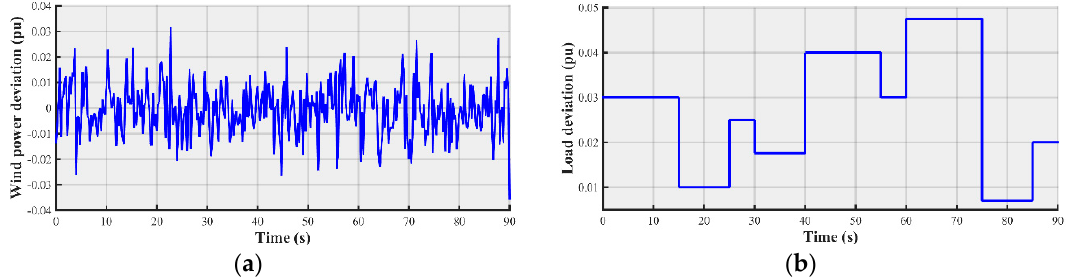
Figure 9. Second scenario: ( a ) wind power deviation and ( b ) random load change.